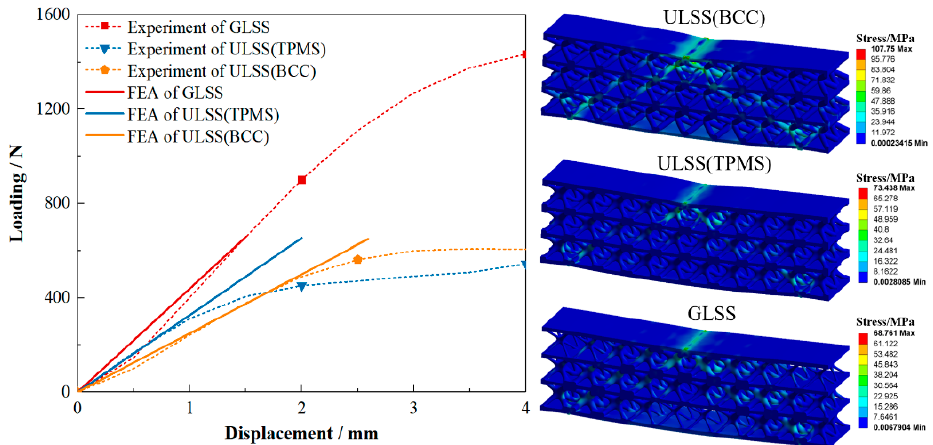
Figure 21. Loading and displacement curves from three-point bending tests of the printed LSSs.